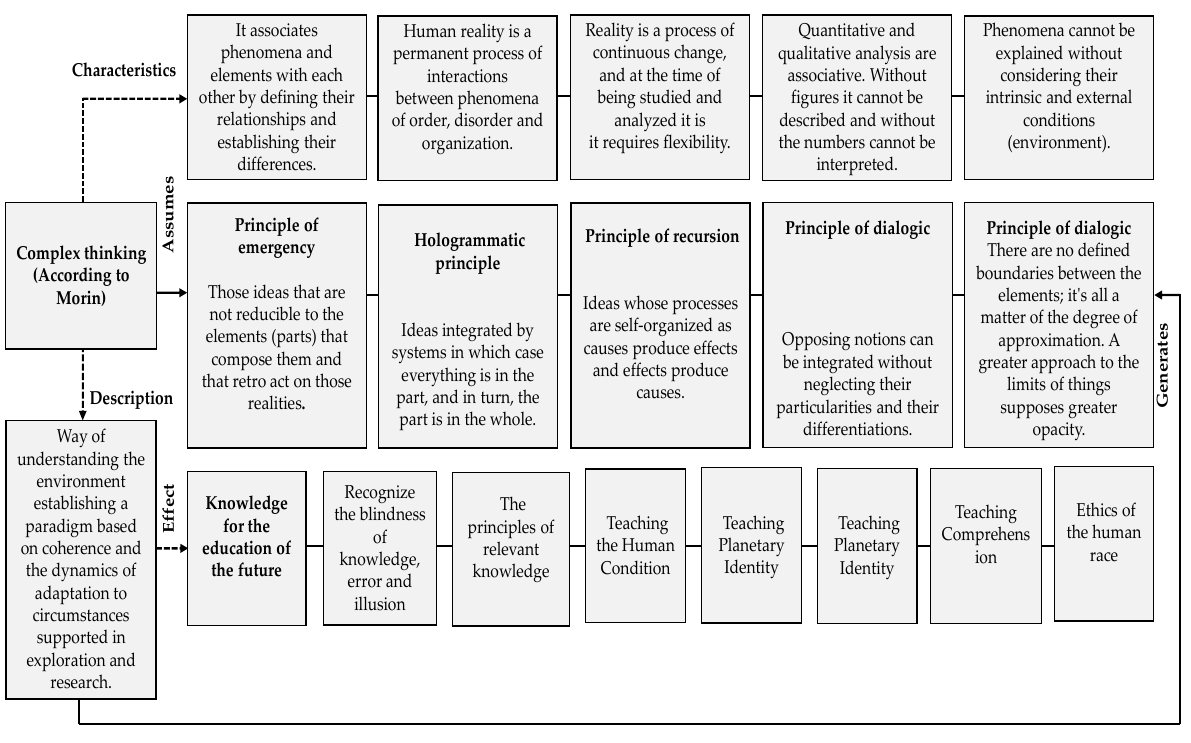
Figure 1. Some characteristics of complex thinking. Source: own elaboration based on Salcedo (2014).